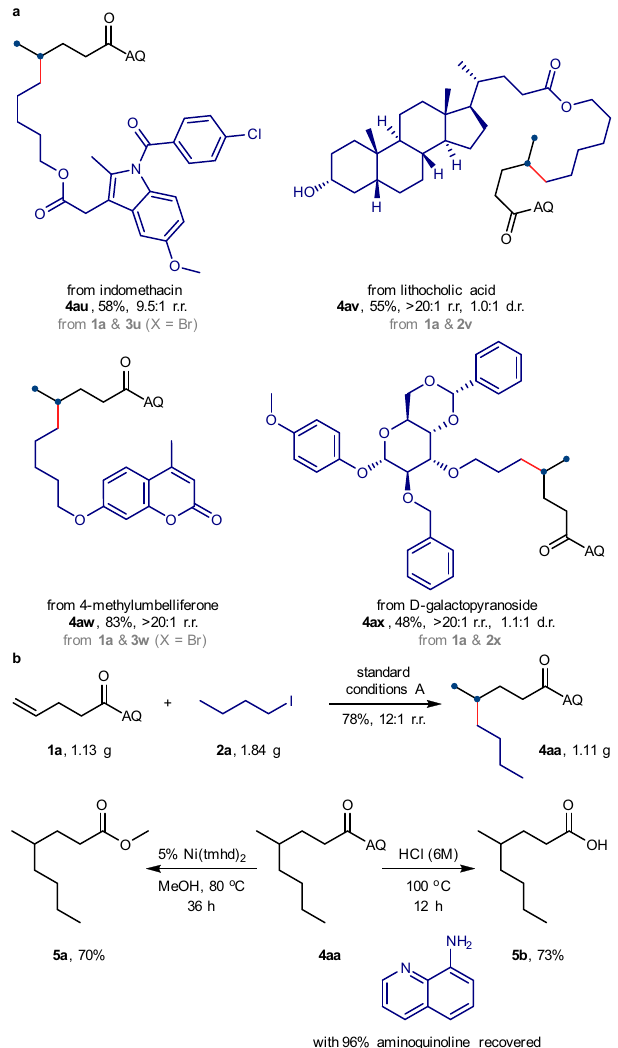
Fig. 3 Synthetic applications. a Late-stage functionalization of biorelevant molecules. b Gram-scale reaction and removal of the directing